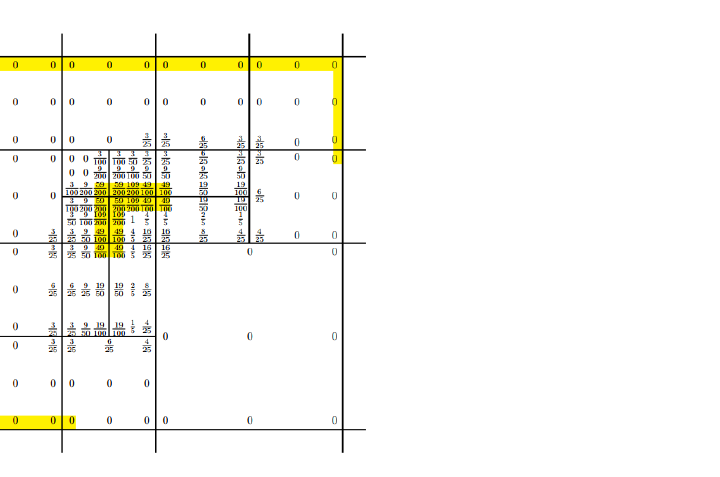
Figure 11. The process of B-ordinates calculation. The values in the highlight domain are the new evaluated B-ordinates on the corresponding domain points.